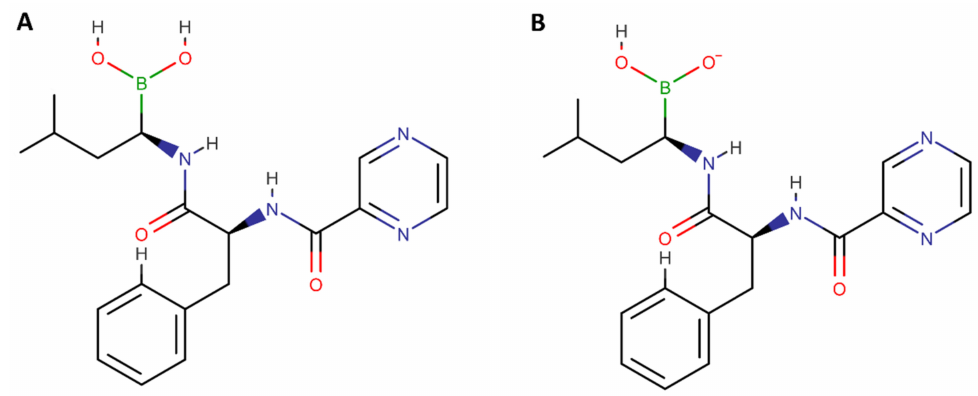
Figure 2. Chemical structures of the existing macrospecies of BTZ at pH ( A ) 6.5 and ( B ) 7.4 (drawn in ACD/ChemSketch).